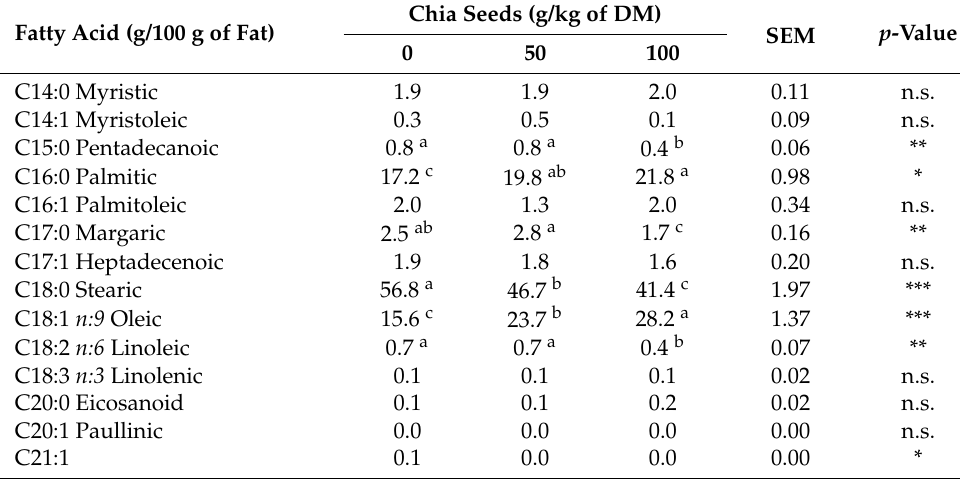
Table 4. Effect of addition of chia seeds to the diet on the fatty acid profile (g/100 g of FAME) of lamb meat ( Longissimus thoracis